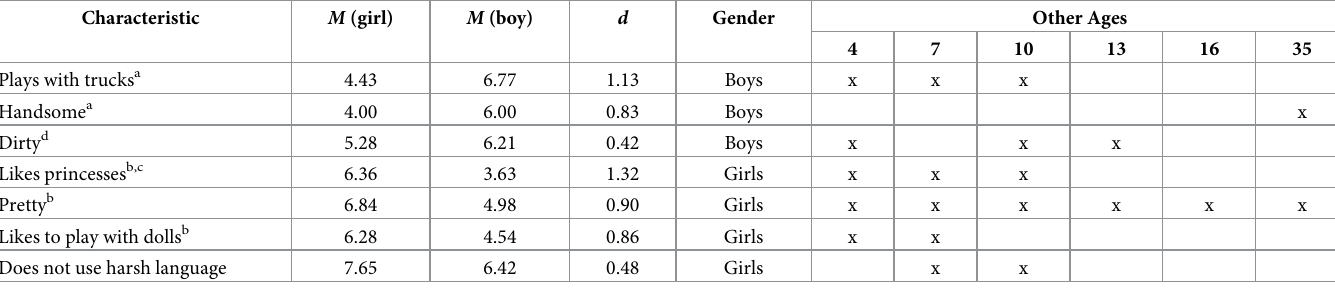
Table 8. Characteristics that were rated as descriptive of one-year-old